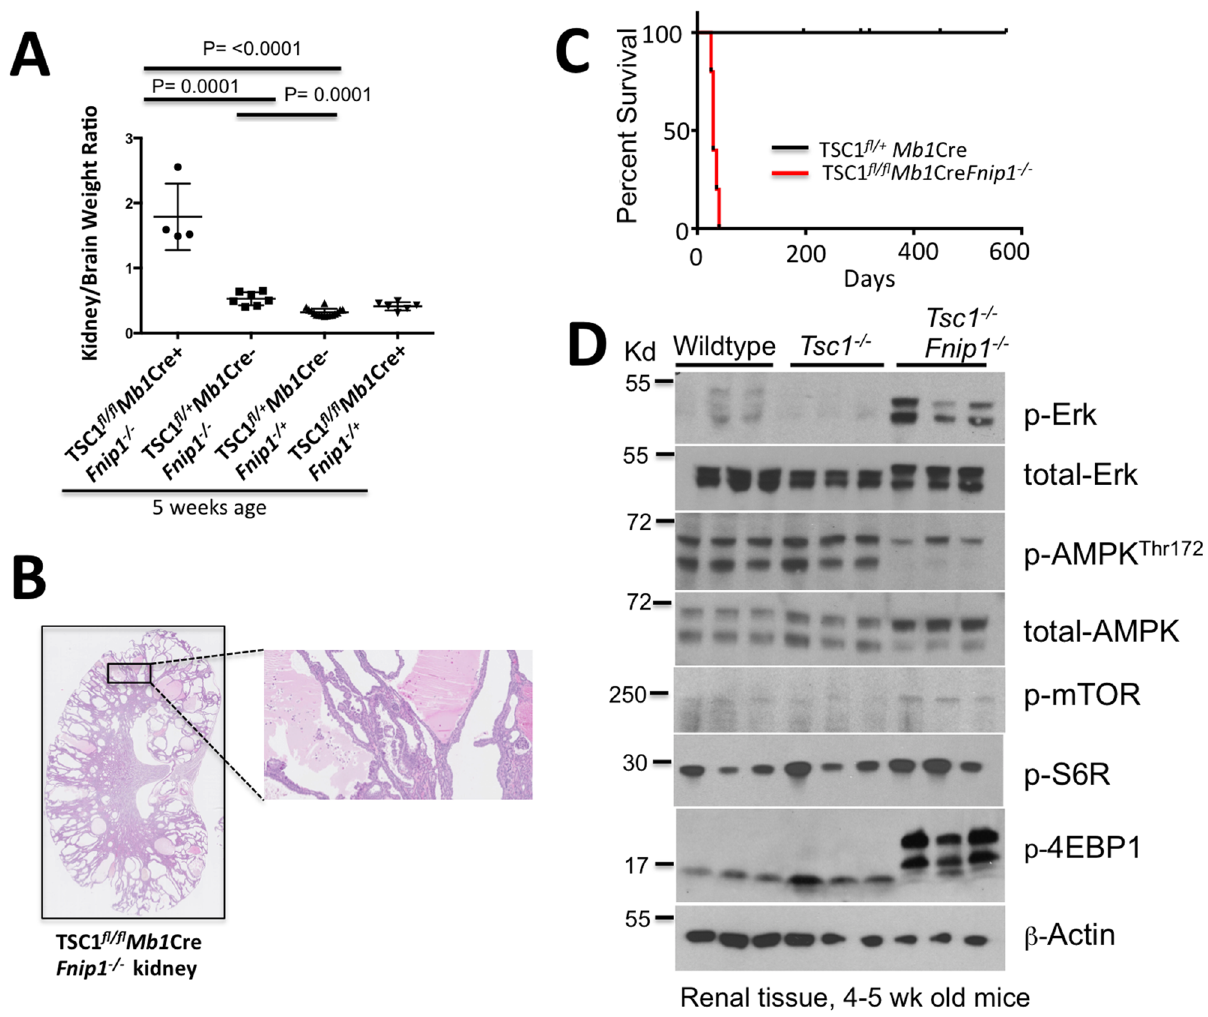
Fig 8. Loss of Fnip1 synergizes with loss of TSC1 resulting in accelerated PKD and mTOR activation. (A) Kidney-to-brain ratio graph comparing double null ( Tsc1 fl/fl Mb1 Cre + Fnip1 -/- ), Fnip1 -/- ( Fnip1 -/- Tsc1 fl/+ Mb1 Cre-), Tsc1 null ( Fnip1 -/+ Tsc1 fl/fl Mb1 Cre + ), and heterozygous ( Fnip1 -/+ Tsc1 fl/+ Mb1Cre - ) mice at 5 weeks of age, showing an increase in kidney size of double null mice at an early age. (B) Representative histology image of Tsc1 fl/fl Mb1 Cre + Fnip1 -/- double null mice showing the development of severe polycystic kidney disease at 5 weeks of age. (C) Kaplan Meier survival graph of Tsc1 fl/fl Mb1 Cre + Fnip1 -/- double null and Tsc1 fl/+ Mb1 Cre + Fnip1 -/- mice. Double-null mice develop PKD very early in life, indicating that loss of Fnip1 in Tsc1 null mice greatly accelerates the onset of PKD relative to Tsc1 loss alone. (D) Immunoblots of proteins isolated from whole kidney lysates derived from 5 week-old wildtype, Tsc1 -/- , and Tsc1 -/- Fnip1 -/- blots showing increased p-Erk, p-S6R, and p-4E-BP in Tsc1 -/- Fnip1 -/- kidney tissue compared to Tsc1 -/- and WT mice indicating hyperactivation of the mTORC1 and Erk pathways. p-AMPK is decreased in double null mice relative to Tsc1 -/- and WT mice, suggesting decreased AMPK activation. (n = 3 each genotype, p-values are